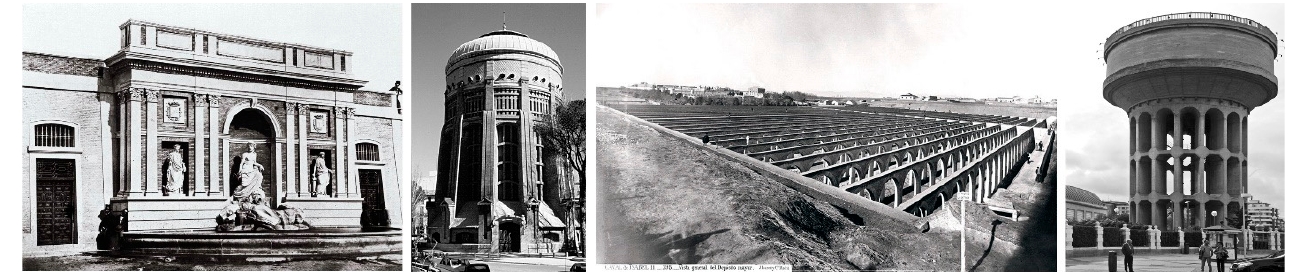
Figure 7. Tanks: Primer Depósito-Campo de Guardias (1858), Santa Engracia water tower (1912), Tercer Depósito (1893) and Plaza de Castilla water tower (1939; relocated in 1952). Source: Charles Clifford and FMA.